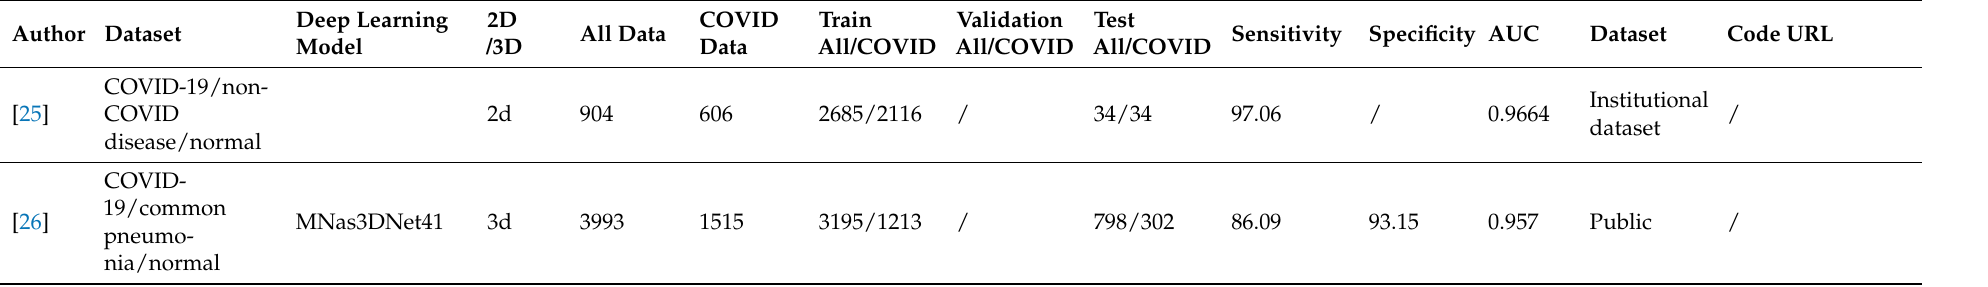
Table 4. Summary of results from AI Studies for CT COVID-19